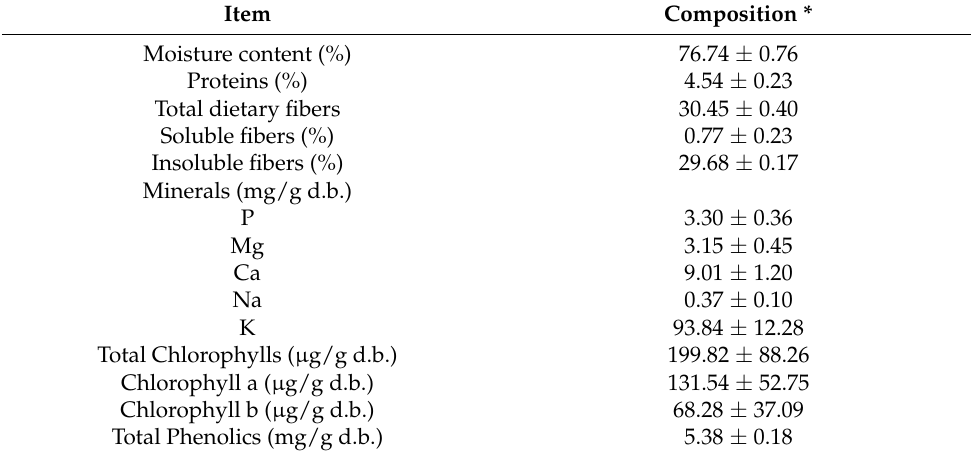
Table 1. Composition of the kiwi peel. Item Composition